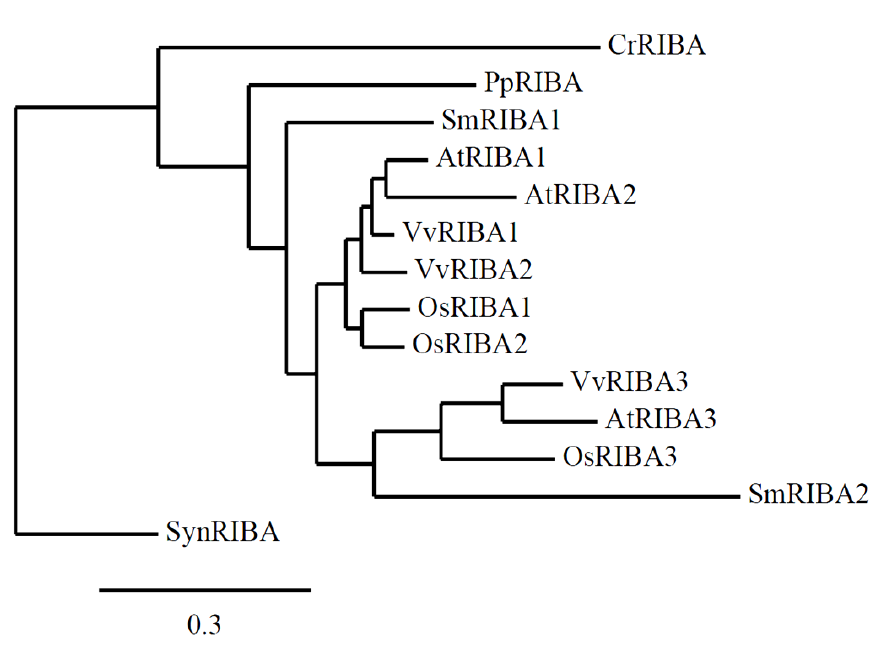
Figure 6. Phylogenetic tree of selected plant RIBA protein sequences. RIBA gene families identified in the angiosperm species Arabidopsis thaliana (At), Vitis vinifera (Vv) and Oryza sativa (Os), two RIBA proteins from a lycopodiophyte species ( Selaginella , Sm), as well as single RIBA sequences from a moss ( Physcomitrella , Pp), a green algae ( Chlamydomonas , Cr), and a cyanobacterium ( Synechococcus , Syn) are included in the analysis. Alignment (using MUSCLE 3.7 and Gblocks 0.91b), phylogenetic analysis (PhyML3.0 aLRT) and tree rendering (TreeDyn 198.3) were performed using the phylogeny resource (http://www.phylogeny.fr) [29], the tree was re-rooted using SynRIBA as outgroup. Full length RIBA amino acid sequences of the following species were used: Arabidopsis thaliana (accession nrs. NP_201235, NP_179831, NP_568913), Chlamydomonas reinhardtii (XP_001689850), Oryza sativa (NP_001047195, BAD09287, NP_001055757), Physcomitrella patens (XP_001770447), Selaginella moellendorfii (XP_002962016, XP_002960875), Synechococcus sp . PCC 7002